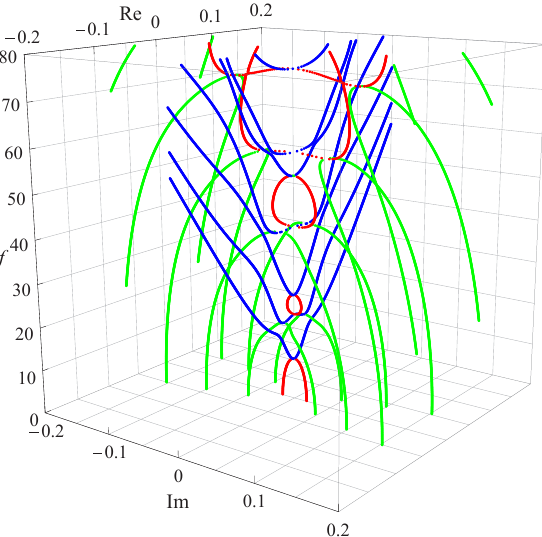
Figure 3. Dispersion curves of complex Rayleigh waves for n = 0.5: blue for real, red for imaginary, and green for complex